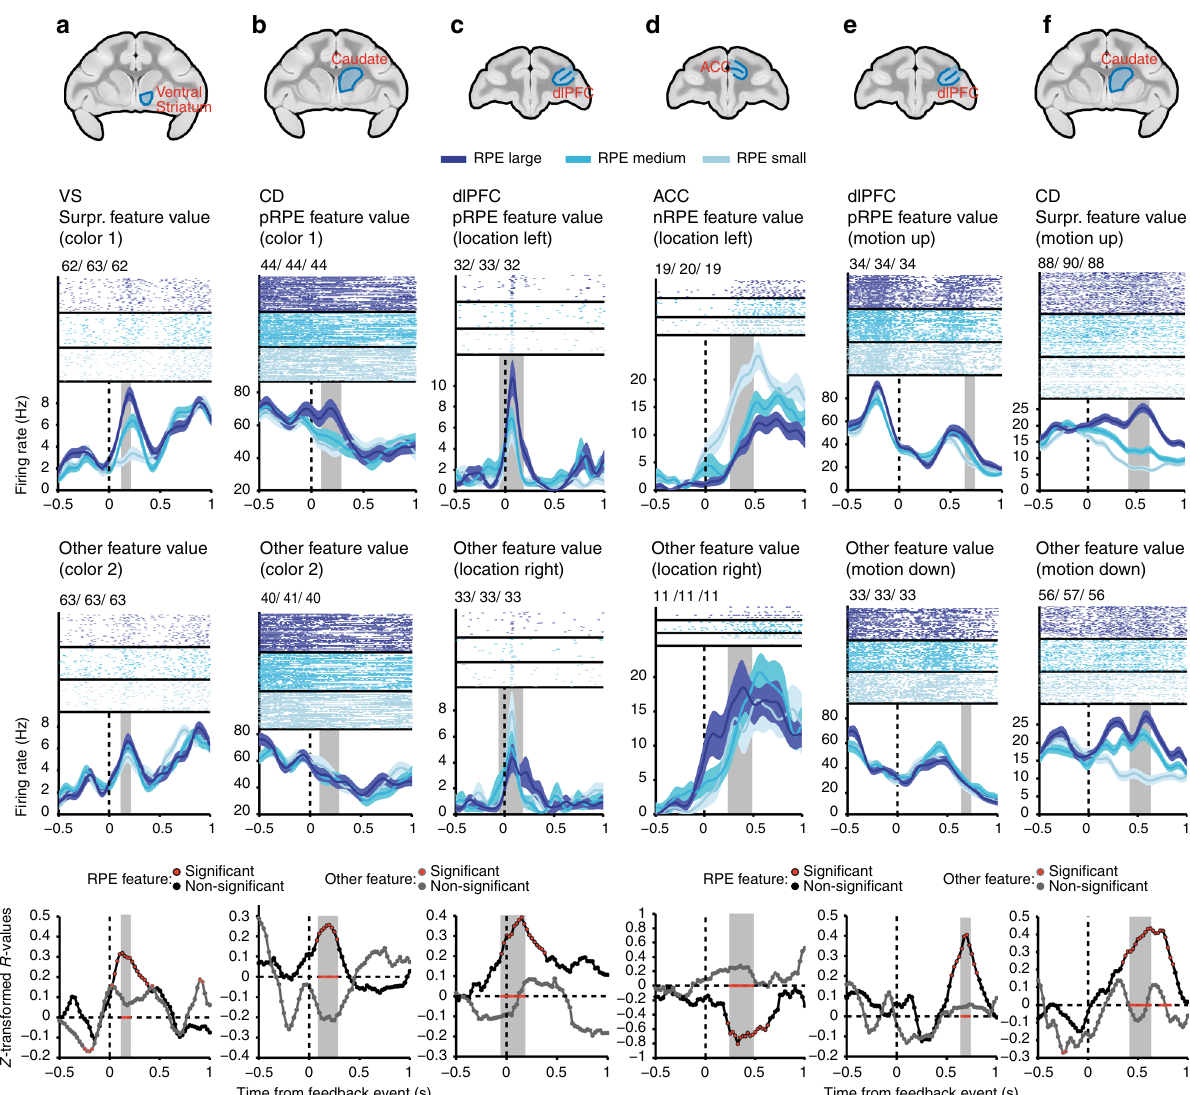
Fig. 3 Example neurons encoding feature-speci fi c RPE signals. For each of six example neurons ( a – f ), the spike rasters and spike-density functions are displayed (for visualization purposes only) for prediction error values of three different magnitudes (trials evenly split into RPE large, RPE medium, and RPE small), for the feature (e.g., color 1) for which an RPE was encoded (preferred RPE feature, top row), and for the feature for which an RPE was less or not encoded (e.g., color 2, nonpreferred RPE feature, and middle row). The bottom most row displays the z -transformed R values of the correlation between spike rate and RPE for the two feature values above (solely this last row displays the statistical analyses performed). Black (nonsigni fi cant) or red fi lled (signi fi cant) circles represent z-transformed R values of the correlation between spike rate and RPE for preferred RPE feature trials. Gray (nonsigni fi cant) or red fi lled (signi fi cant) outlines represent z-transformed R values of the correlation between spike rate and RPE for nonpreferred RPE feature trials (Spearman correlation). Red stars indicate those time bins for which the R values between the two feature values differed signi fi cantly ( Z -test, see Methods, Eq. ( 1)). Gray transparent bars in all plots indicate the time window of RPE encoding. Small numbers at the top left of each subplot containing spike rasters indicate the numbers of trials that were included in the RPE large/RPE medium/RPE small groups, respectively. The title above each column of fi gures indicates the area that neuron was recorded from as well as the type of feature and RPE signal encoded by that neuron. Anatomical images at the top-most additionally illustrate the recording locations. Shaded error bars represent SEM. Imaging data provided by the Duke Center for in